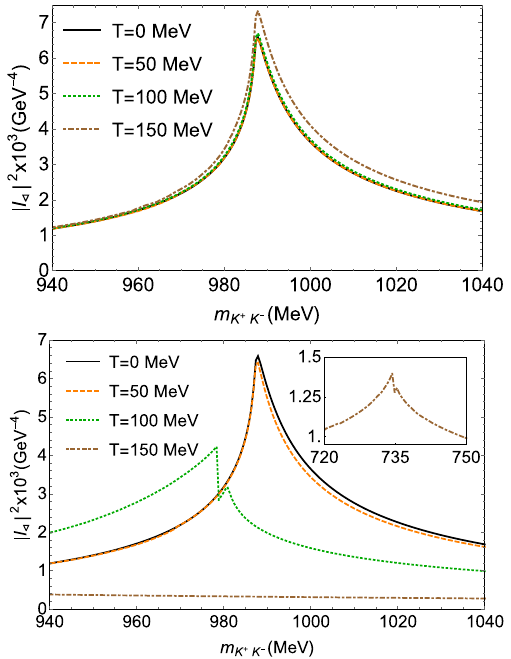
Fig. 3 Squared scalar triangle loop integral ( | I (cid:4) | 2 ) in Eq. (6) for the reaction of Eq. (9), as a function of the K + K − invariant mass [4,8], for various temperatures. The intermediate particles 1, 2 and 3 are respectively K ∗+ , K − and K + , with fixed K ∗+ K − invariant mass at 1420 MeV. Top: temperature included only in the loop variable q 0 , but M i , Γ i fixed at their vacuum values [24] except for a regulating Γ = 0 . 5 MeV to avoid numerical instability (so the T = 0 peak 2 is estimated from below). The effect of T is smaller than in Fig. 2, due to m K >> m π ∼ T . Bottom: thermal corrections to the ( 1 , 2 , 3 ) meson masses and widths are included, according to the values shown in Table 1. The singularity melts with